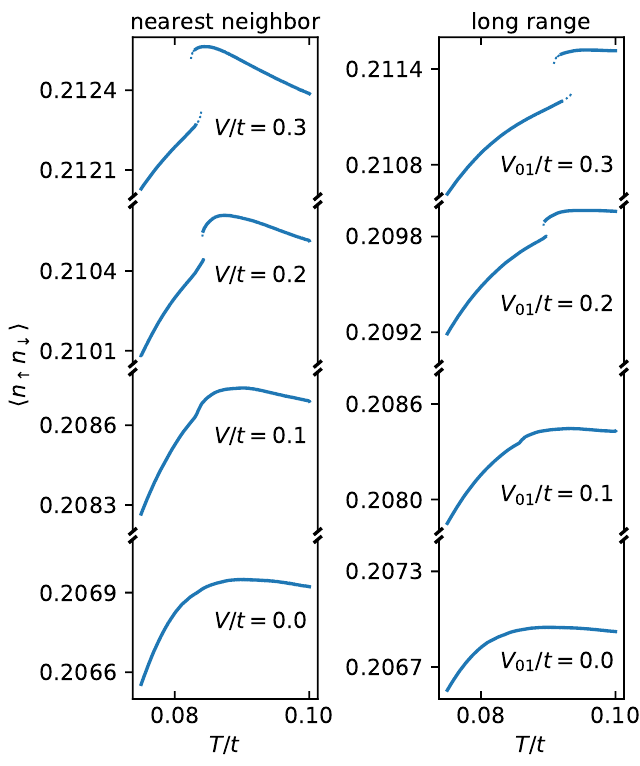
Figure 2: Temperature dependence of the double occupancy for U / t = 1.9 and in- creasing non-local interaction strength (left: nearest-neighbor, right: long range). The dotted lines show coexisting metastable